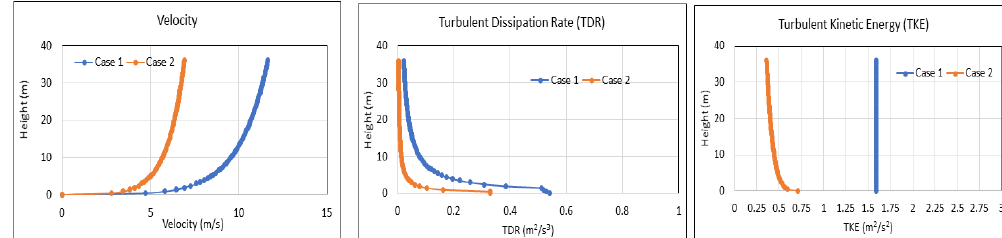
Figure 5. The inlet boundary conditions for Cases 1 and 2, as per Table 2. For Case 3, the inlet velocity, turbulent kinetic energy, and dissipation rate profiles were based on the outlet values of Case 2.